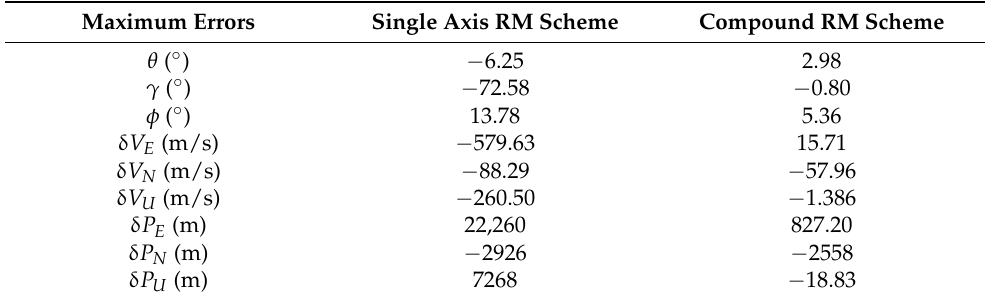
Figure 24. Comparison of velocity and position results in three directions: ( a ) comparison of velocity results in three directions; ( b ) comparison of position results in three directions. Table 10. Maximum errors between two rotational modulation schemes